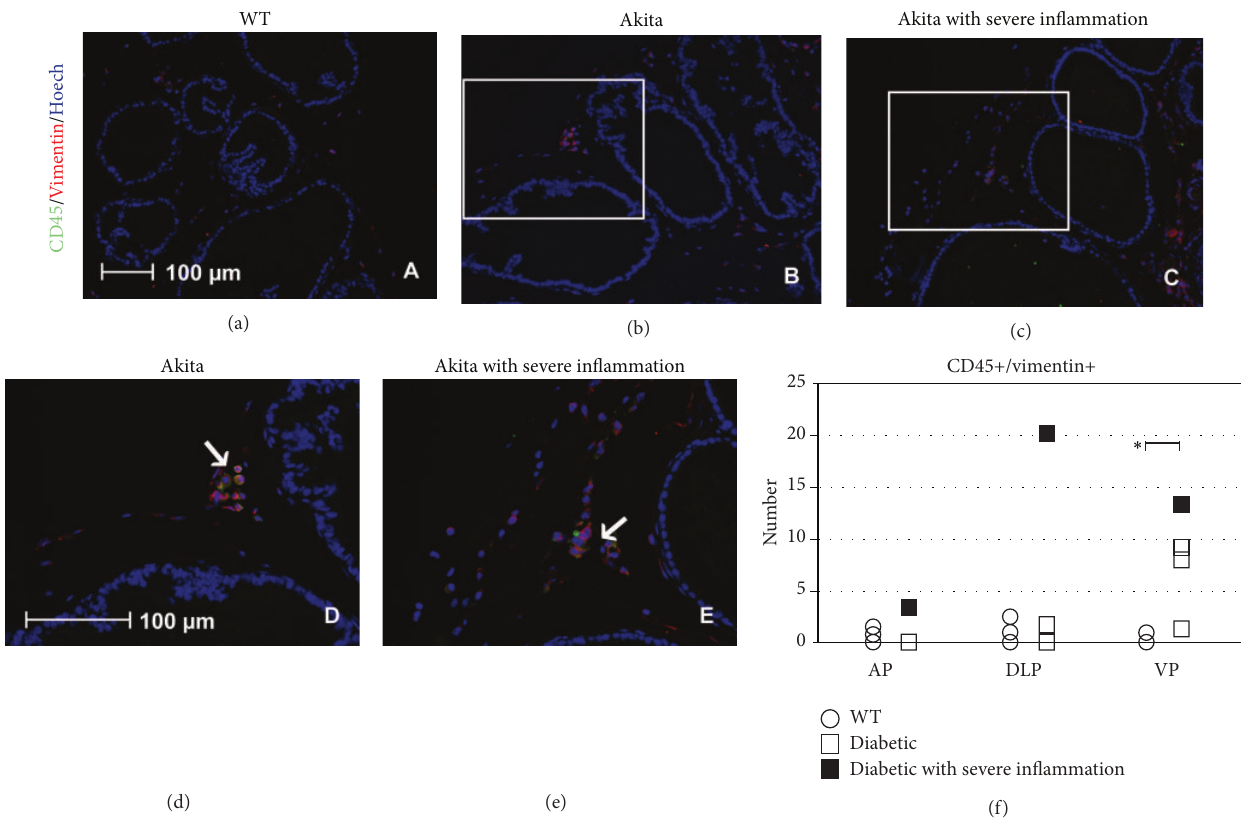
Figure 4: Representative section of the VP of 18-week-old DBA2J (WT; (a)), DBA2J.Ins2-Akita (diabetic; (b), (d)), or DBA2J.Ins2-Akita with severe inflammation (diabetic; (c), (e)) stained for CD45 and vimentin. Quantification results of fibrocyte infiltration in the AP, DLP (image not shown), and VP ((f), white circles = WT, white squares = Akita, and black squares = Akita with severe inflammation). ∗ 𝑃 value < 0.05. Arrow denotes CD45+/vimentin+